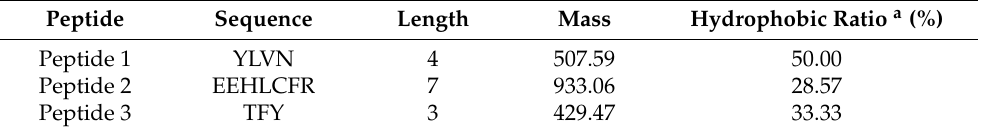
Table 1. Sequence, length, molecular mass and the hydrophobic ratio of three novel antioxidant peptides. Peptide Sequence Length Mass Hydrophobic Ratio a (%) Peptide